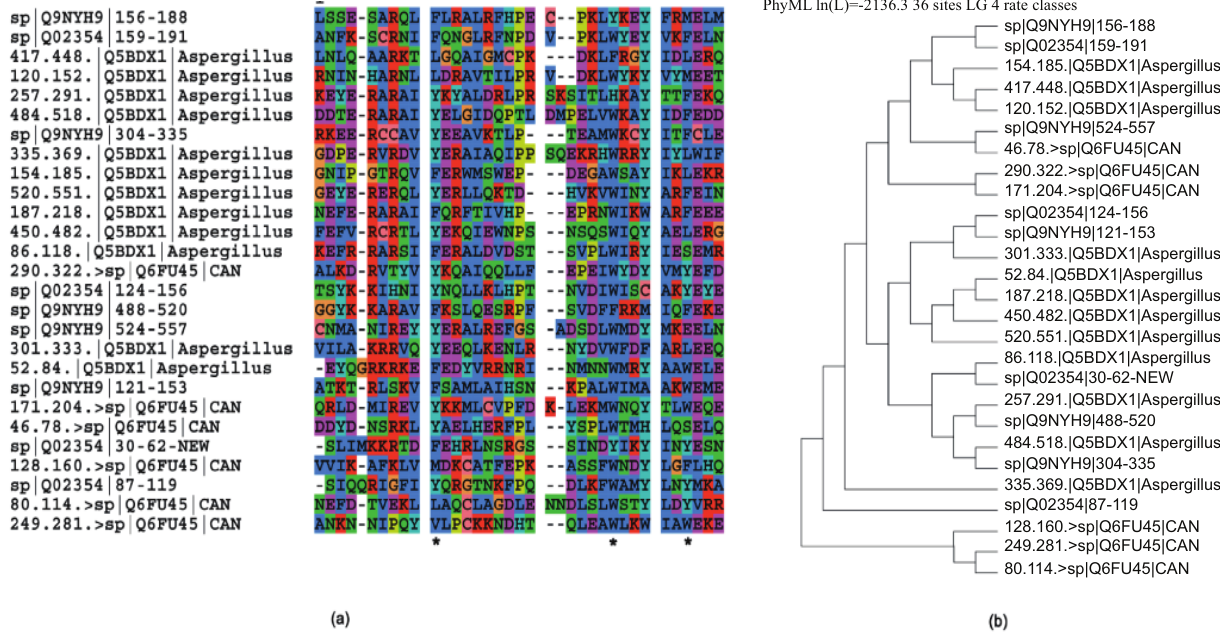
Figure S4. Including more proteins having the HAT motif. ( a ) The multiple alignment for this new sequence (using ClustalW) with other HAT motifs in S. cerevisiae , humans, Aspergillus nidulans and Candida glabrata shows large variation amongst HAT sequences even within the same organism. The conserved spacing of the aromatic residues remains the same. ( b ) Similar to the case when fewer organisms were included, the phylogenetic tree (using PHYML) shows that certain HAT repeats are more similar to HAT repeats from other organisms than to other HAT repeats in its own